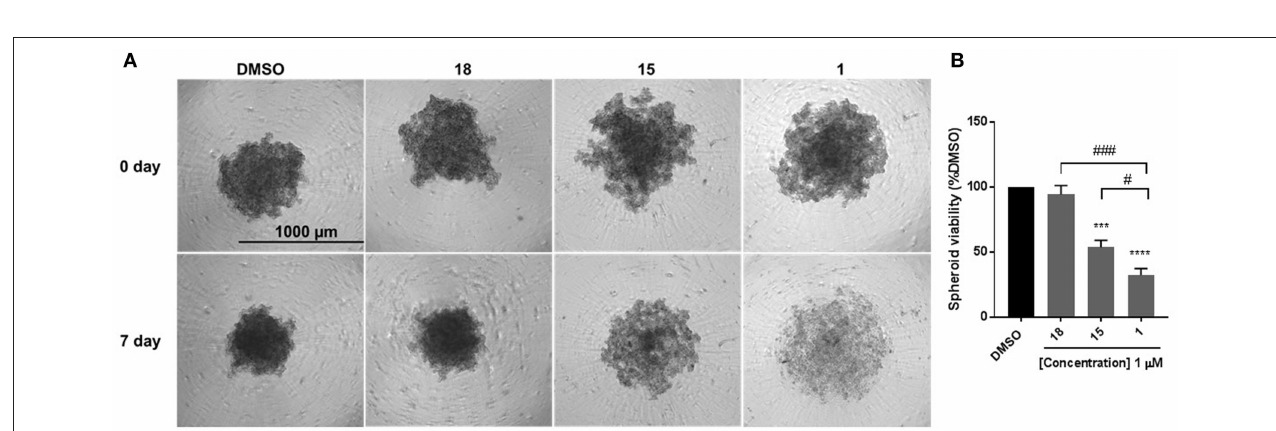
FIGURE 4 | Compound 1 and 15 decrease spheroid viability in MDA-MB-231 cells. (A) Spheroid formation in MDA-MB-231 cells after treatment with DMSO or compounds 18 , 15 , and 1 for 7 days of treatment. (B) Quantification of the spheroid viability in MDA-MB-231 cells, values indicate ± SEM of three experiments run in triplicate. *** p < 0.001, **** p < 0.0001 vs. control group, ### p < 0.001 compound 1 vs. compound 18 # p < 0.05 compound 1 vs. compound 15 determined by one-way ANOVA with the Bonferroni post hoc test in MDA-MB-231